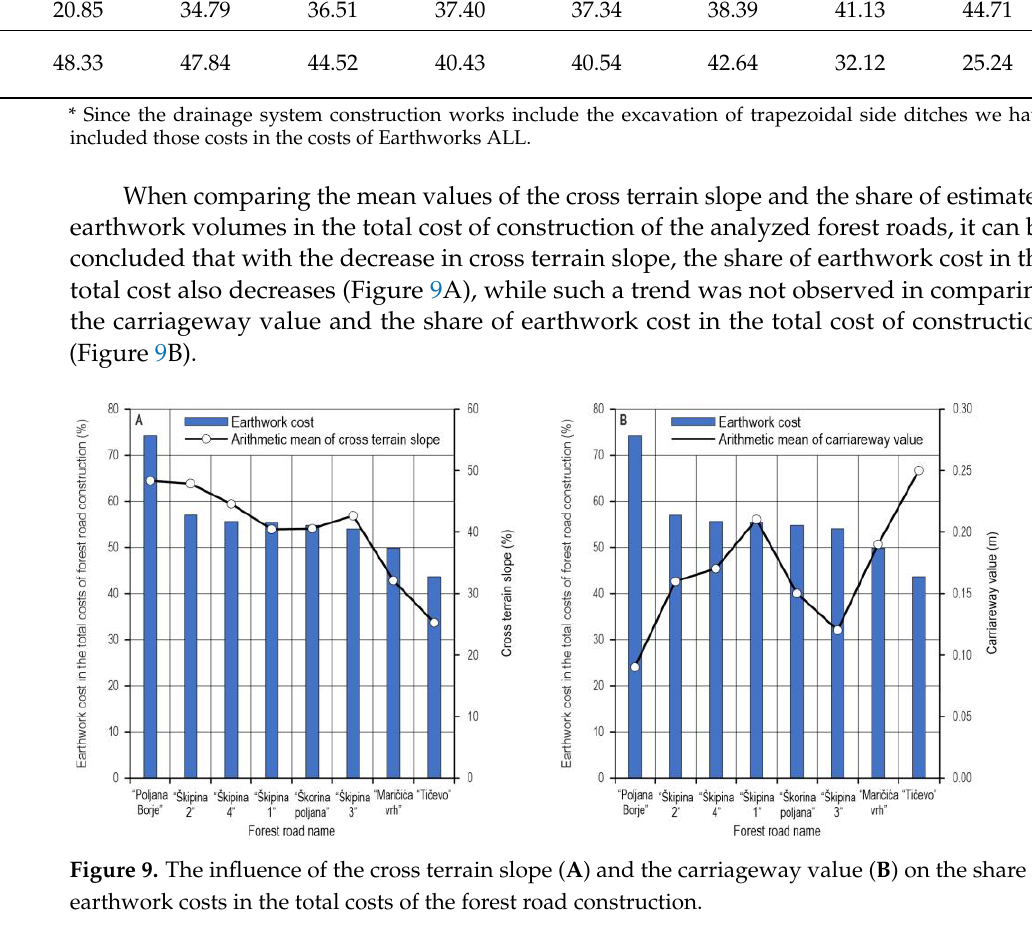
Table 6. Number of cross section profiles per material category.